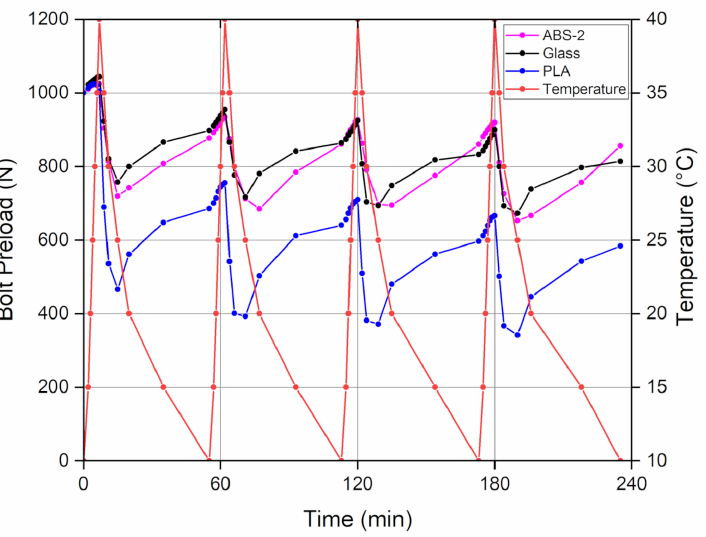
Figure 4. The preload variations of all bolted joints under cyclical temperature changes from 10 ◦ C to 40 ◦ C.